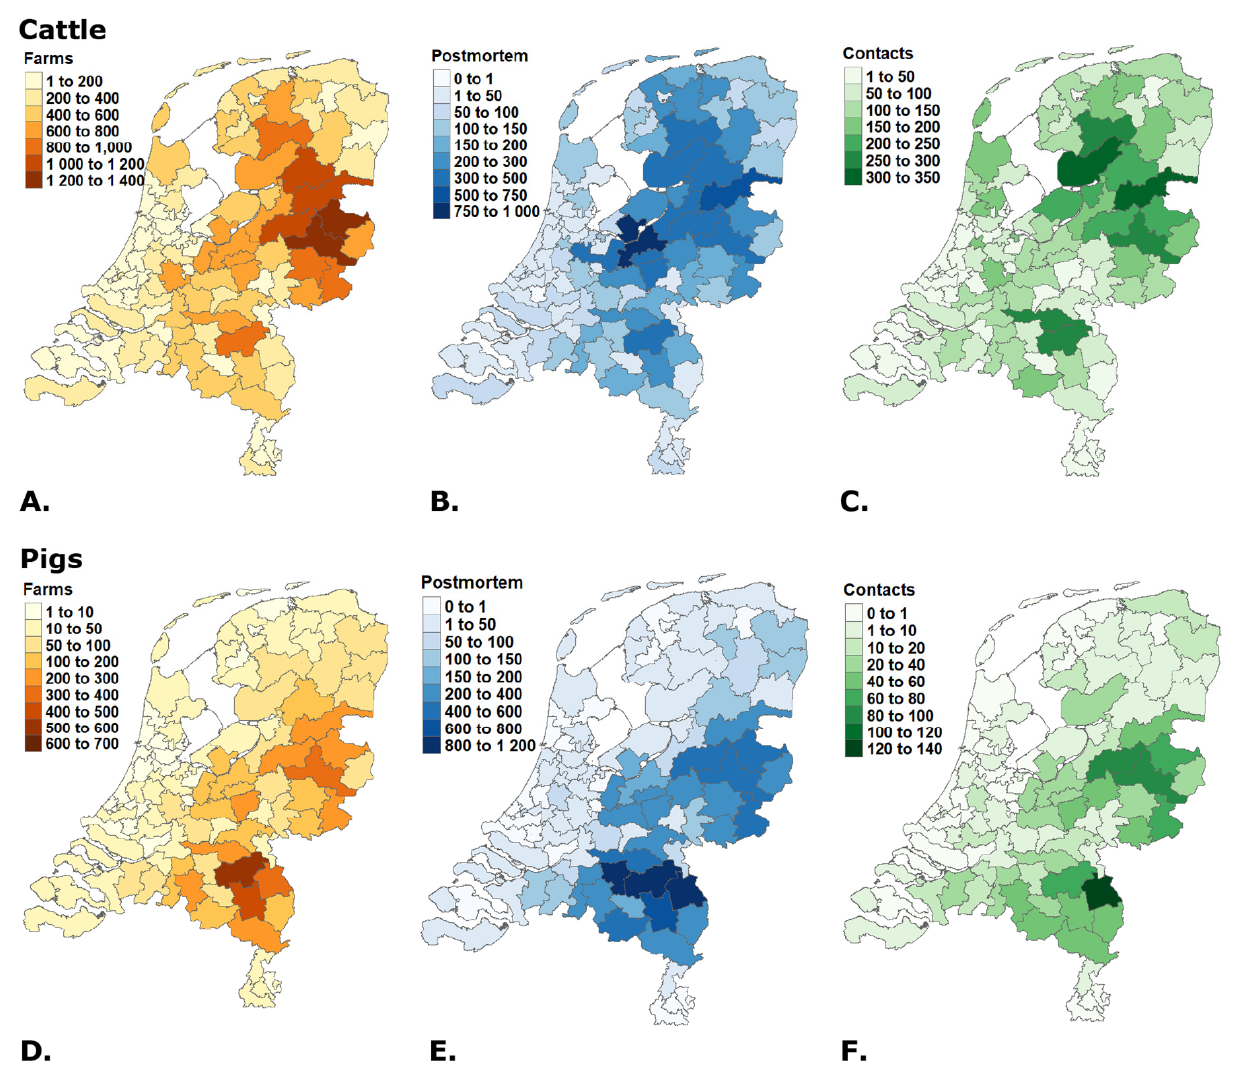
Figure 3. Distribution of farms ( A , D ), postmortem examinations ( B , E ) and helpdesk contacts ( C , F ) for cattle and pigs over the PC2 areas in the Netherlands from 2015 to 2019.